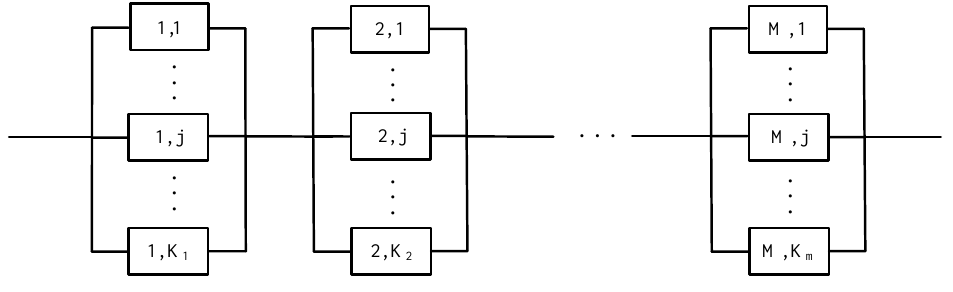
Fig.1. General structure of series-parallel